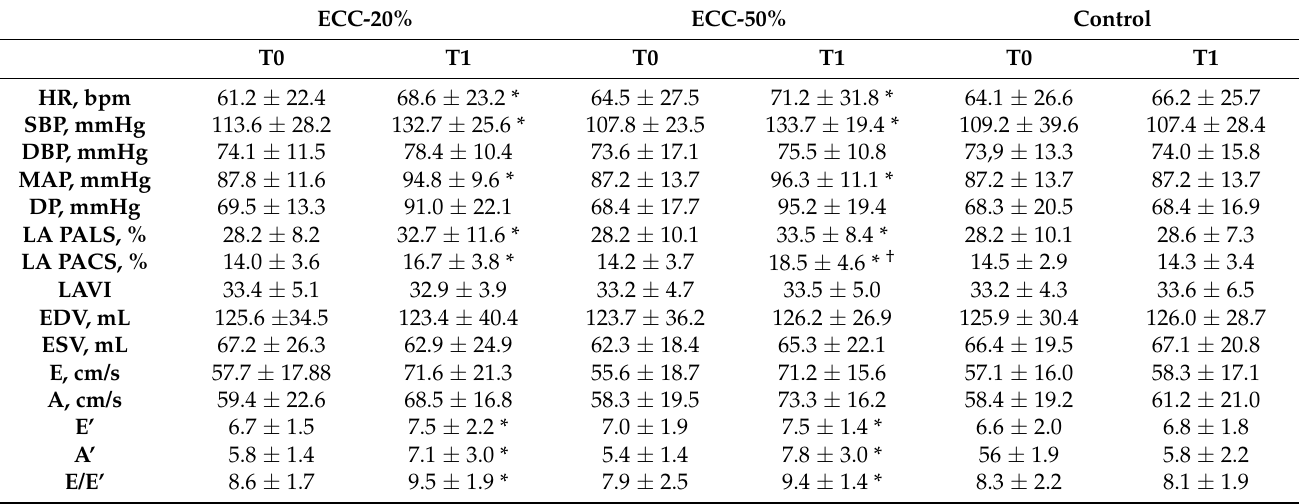
Figure 2. Percentage changes of PALS and PACS after ECC-20 (black-bars), ECC-50 (gray-bars) and control session (dotted bars). Results of ANOVA and post hoc testing. Table 2. Hemodynamic and echocardiography parameters before (T0) and after (T1) exercise Table 1. Anthropometric and clinical characteristics of patients.